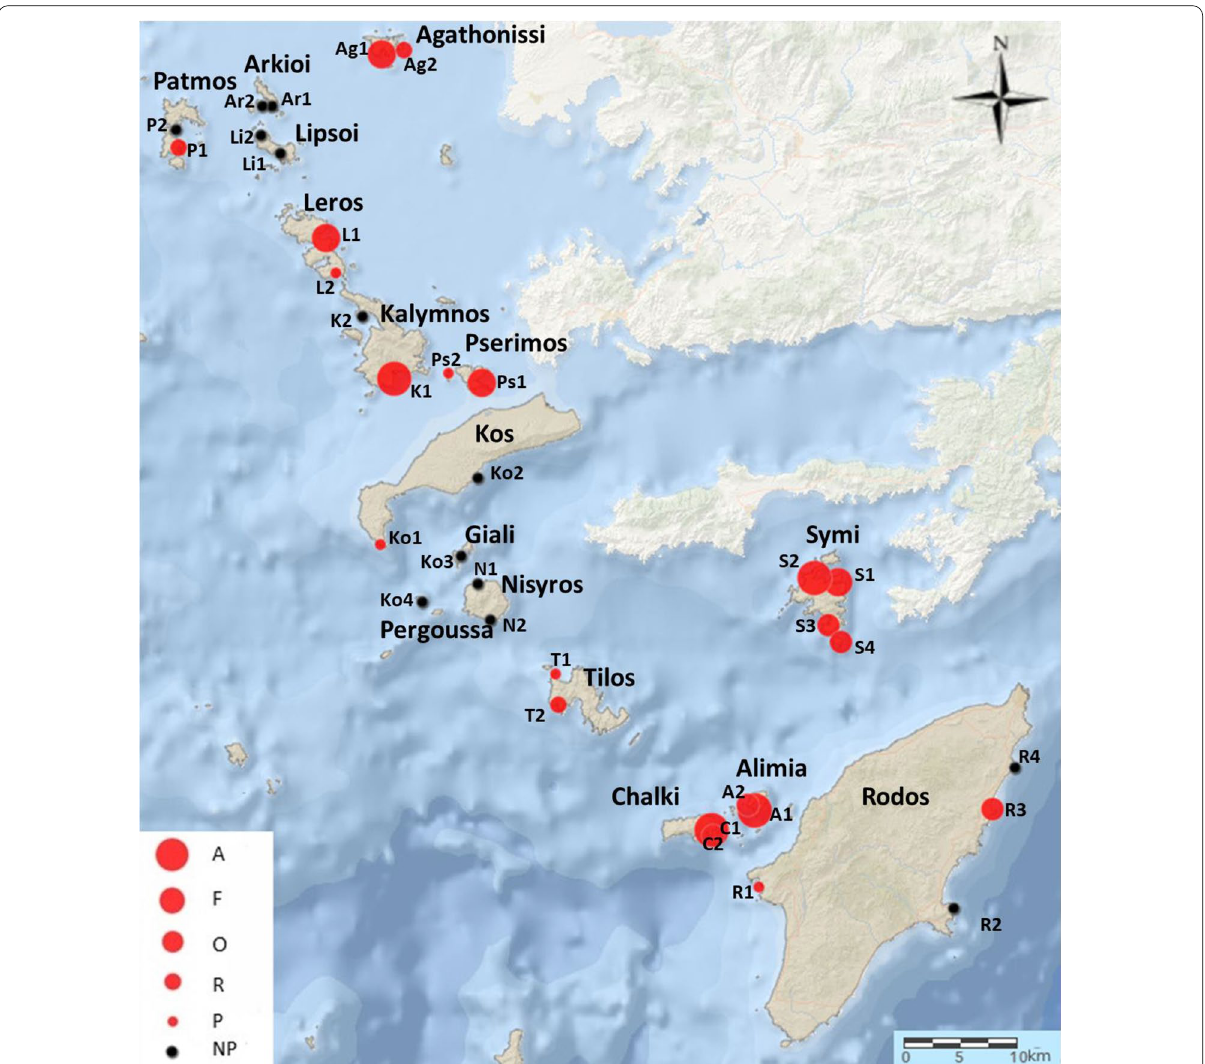
Fig. 1 Sampling stations and relative abundance of Diadema setosum in the marine area of the Dodecanese island complex. A abundant, F frequent, O occasional, R rare, P present, NP no